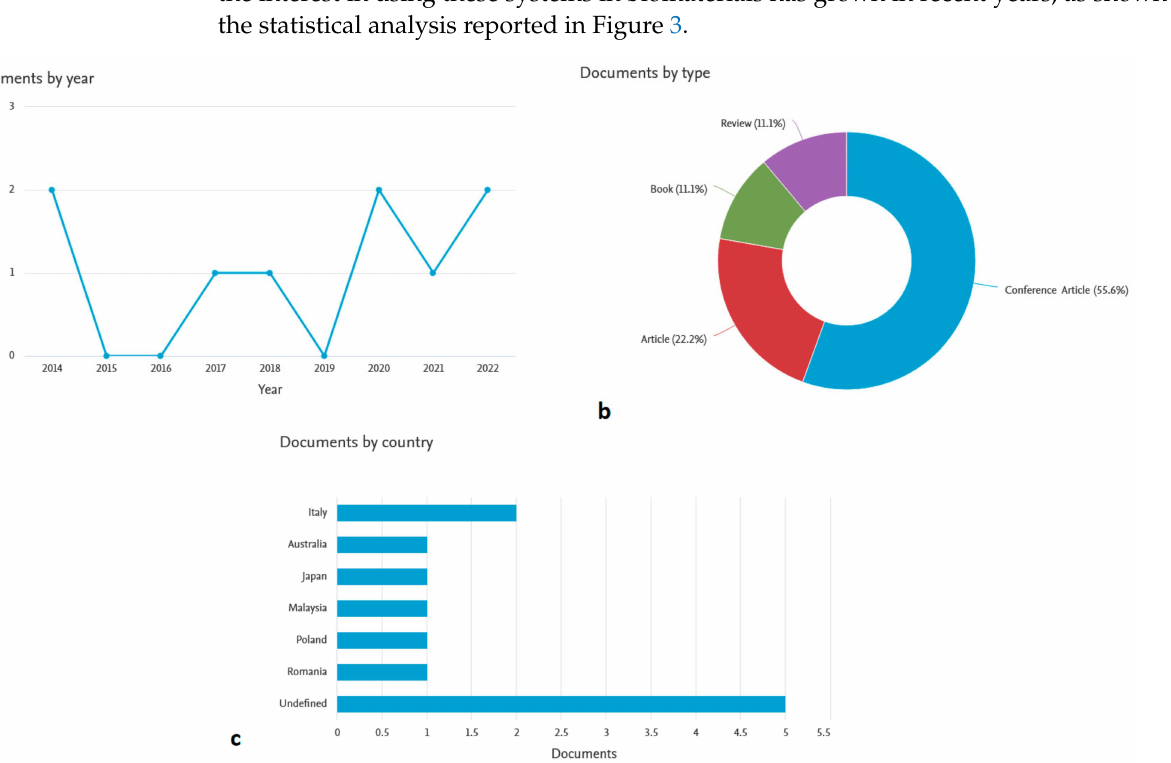
Figure 3. Statistical analysis of published articles on the topic “geopolymers for biomedical appli- cations”: ( a ) number of publications per year, ( b ) types of publications, and ( c ) countries actively involved in article publication. The data were extracted from the Scopus database on 23 January